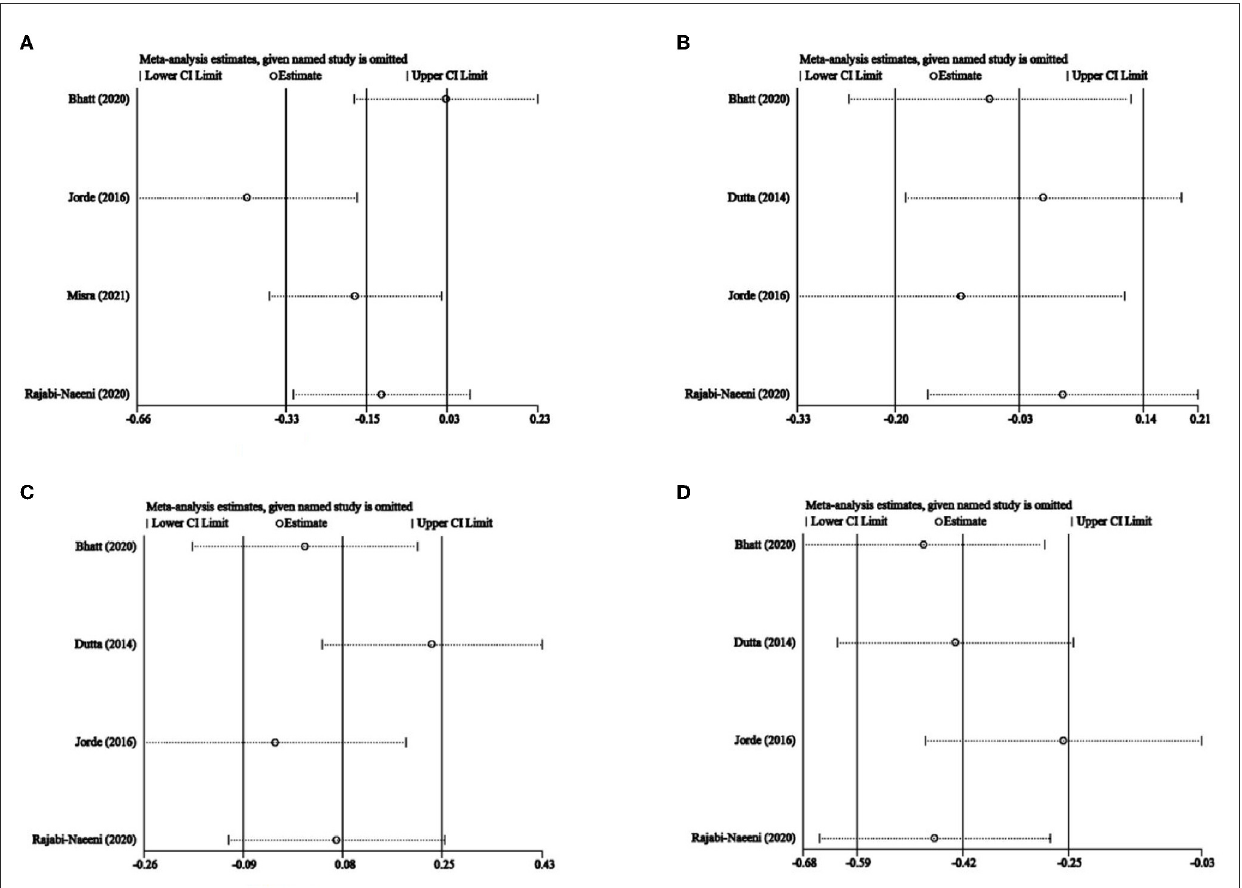
FIGURE10 Influence analysis. (A) TC, (B) LDL-C, (C) , and HDL-C, and (D) TG. TC, total cholesterol; LDL-C, low-density lipoprotein cholesterol; HDL-C, high-density lipoprotein cholesterol; TG,